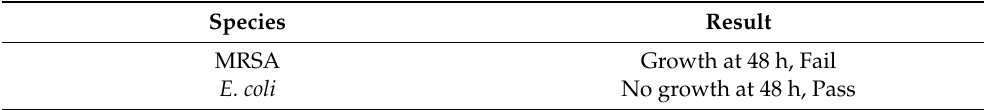
nical replicates. A pass result required at least 2 of the 5 tubes to be clear (i.e., no growth) after 48 h. 48 h.